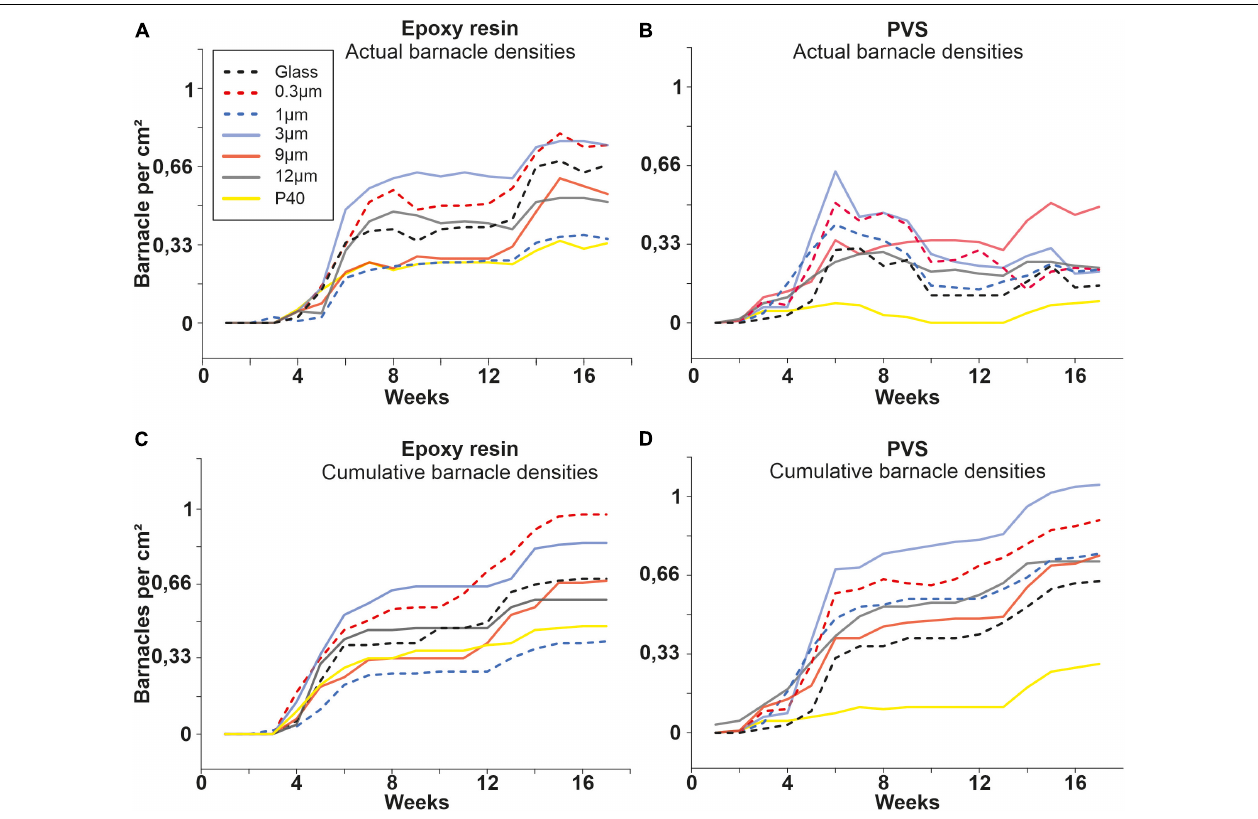
FIGURE 3 | Results of the field experiment 1. (A,B) Actual barnacle densities (total number of barnacles per cm 2 ) for samples made of Epoxy and PVS are subdivided into the seven roughness types. (C,D) Accumulated barnacle densities including all detached